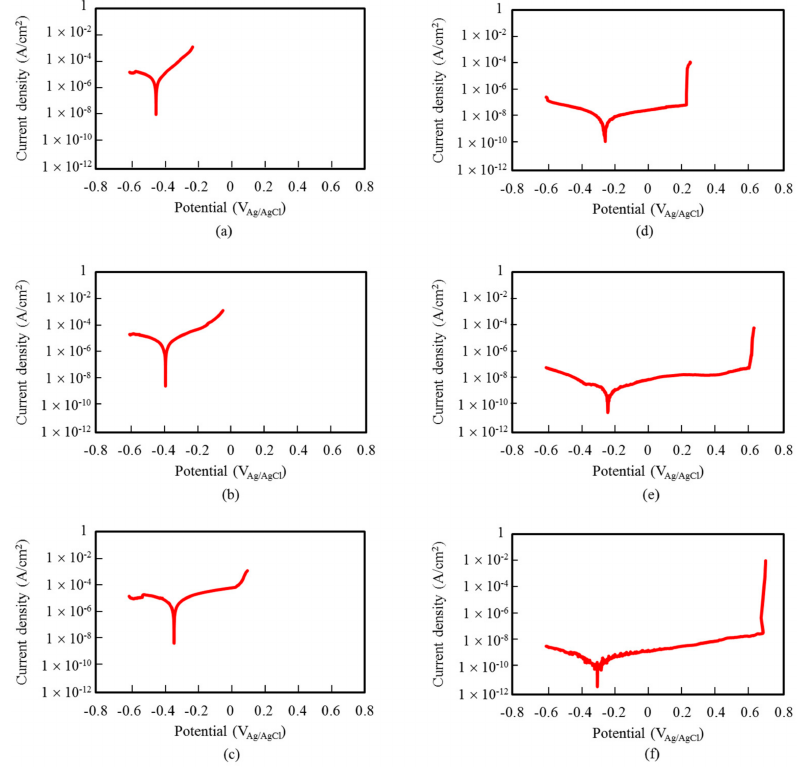
Figure 3. Anodic polarization plots for CG alloys with ( a ) 8%, ( b ) 10% and ( c ) 12% Cr and UFG alloys prepared by ECAP with ( d ) 8%, ( e ) 10% and ( f ) 12%